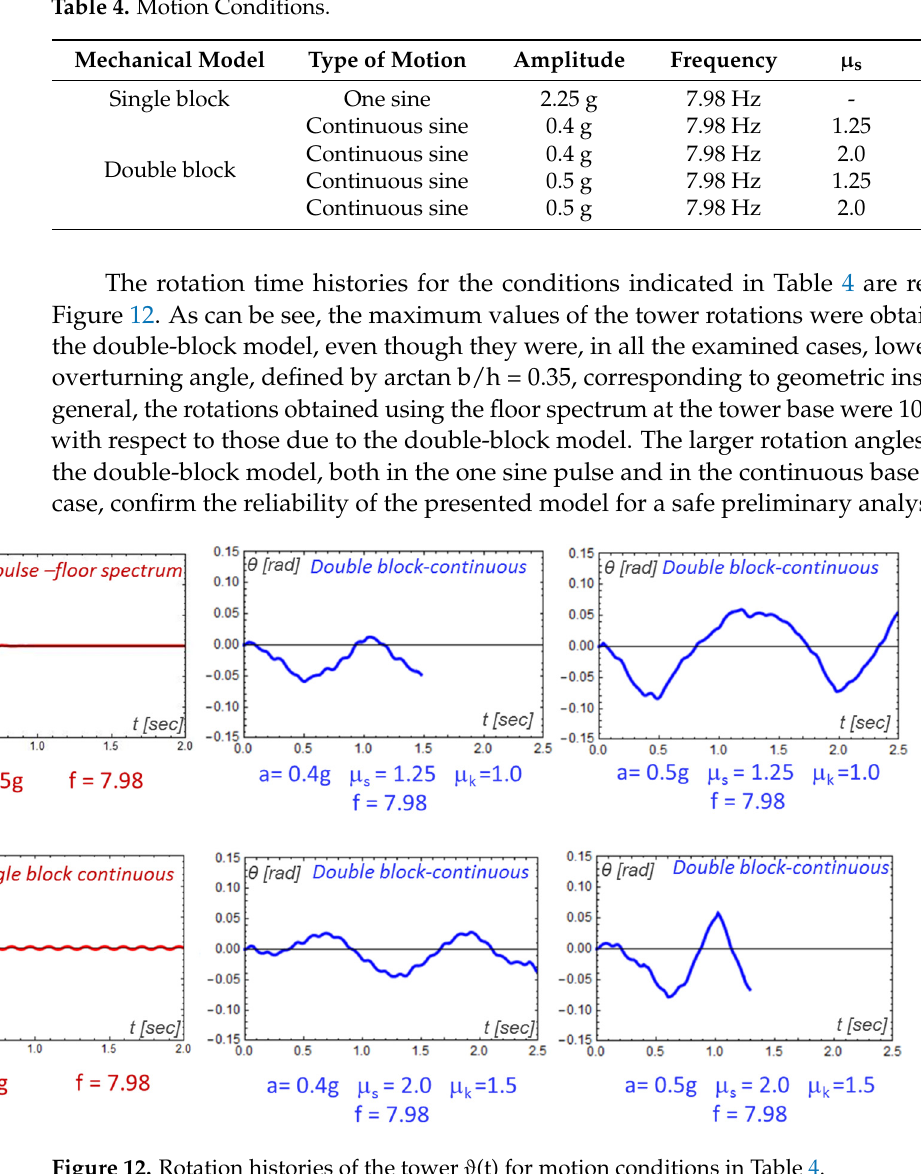
Figure 12. Rotation histories of the tower ϑ (t) for motion conditions in Table 4.